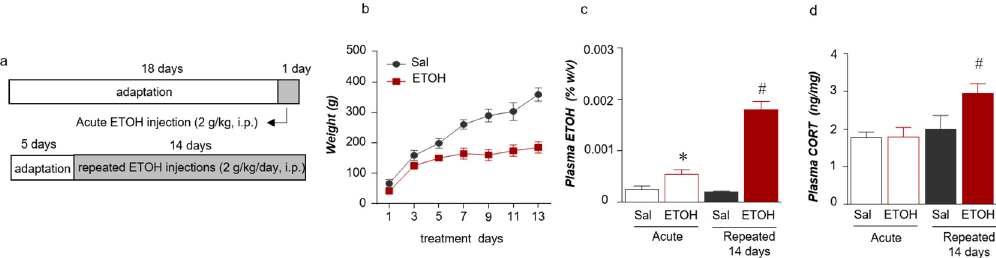
Figure 1. Schematic of the experimental procedure for acute and repeated ETOH administration ( a ). Weight changes were monitored for 13 days (n = 4–5 rats per group) ( b ). Plasma ETOH levels following acute and repeated (14 days) ETOH administration (n = 4–6 rats per group) ( c ). Plasma corticosterone (CORT) levels (n = 6–8 rats per group) ( d ). The data were analyzed using repeated measures one- and two-way ANOVA and t-tests. * p < 0.05 compared with the acute Sal group and # p < 0.05 compared with the repeated Sal group. Values are presented as means ± SEM.